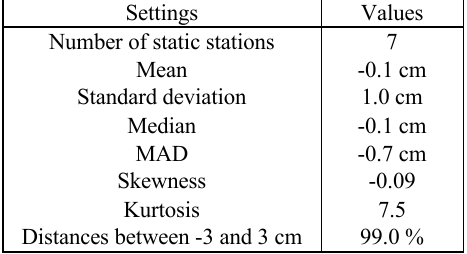
Table 7. Results after segmenting MMS acquisitions and reducing the number of SLS